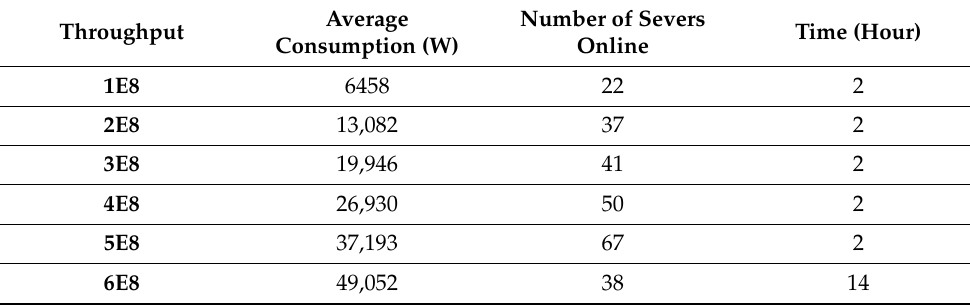
Table 6. Simulation results of data center